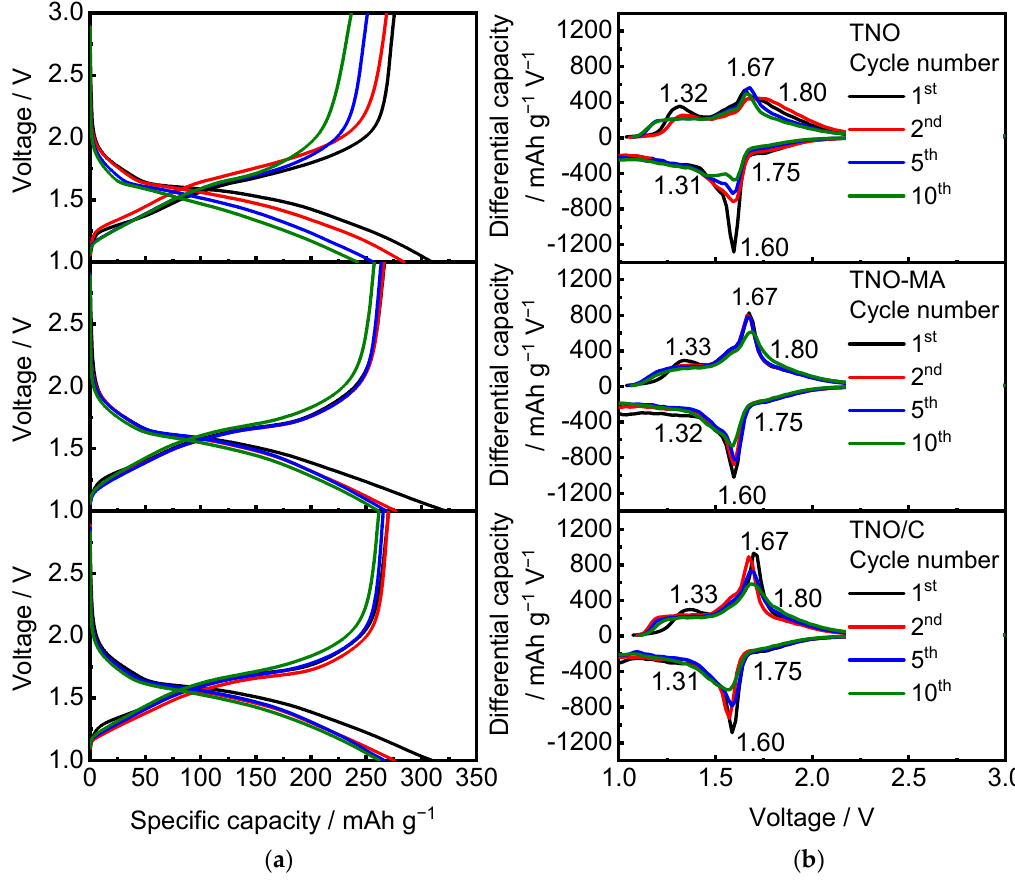
Figure 6. ( a ) Charge–discharge profiles and ( b ) differential capacity vs. voltage plots for TNO, TNO-MA, and TNO/C.